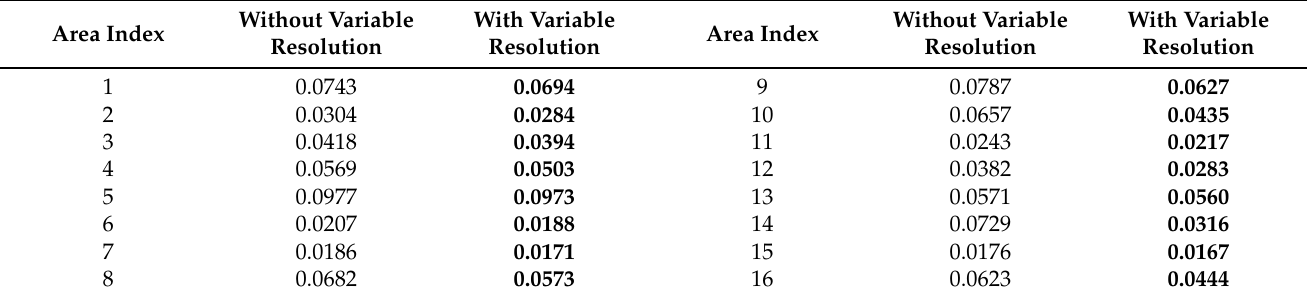
Figure 8. The selected areas of the corridor environment used to calculate the mapping error. Several kinds of regions are selected and colored separately, with each type of region colored in the same color. Areas 1–5 are the ceiling, areas 6 and 7 are the floor, areas 8–13 are the railings, and areas 14–16 are the walls. Table 4. The mapping error (MAE/m) comparison of the corridor